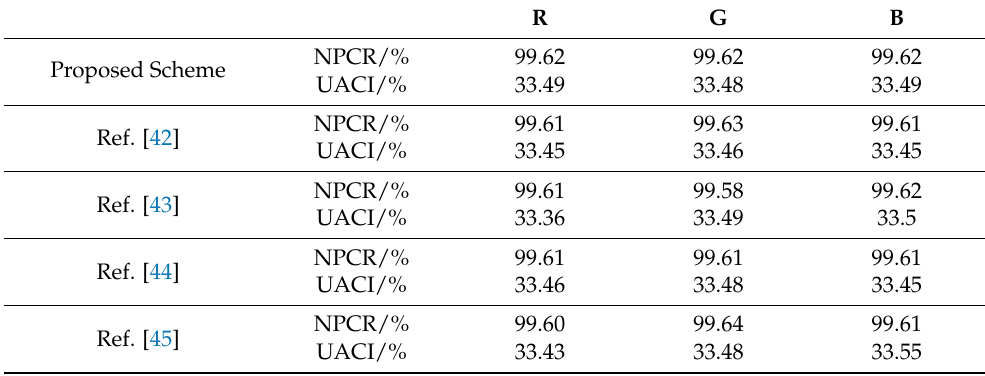
Table 7. Comparison of NPCR and UACI for the Lena by different encryption algorithms.